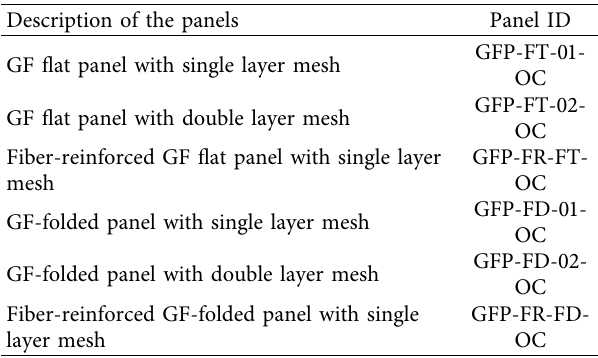
Figure 1: Geometry of GF panels. (a) Flat panel. (b) Folded Table 1: Description of GF panels.